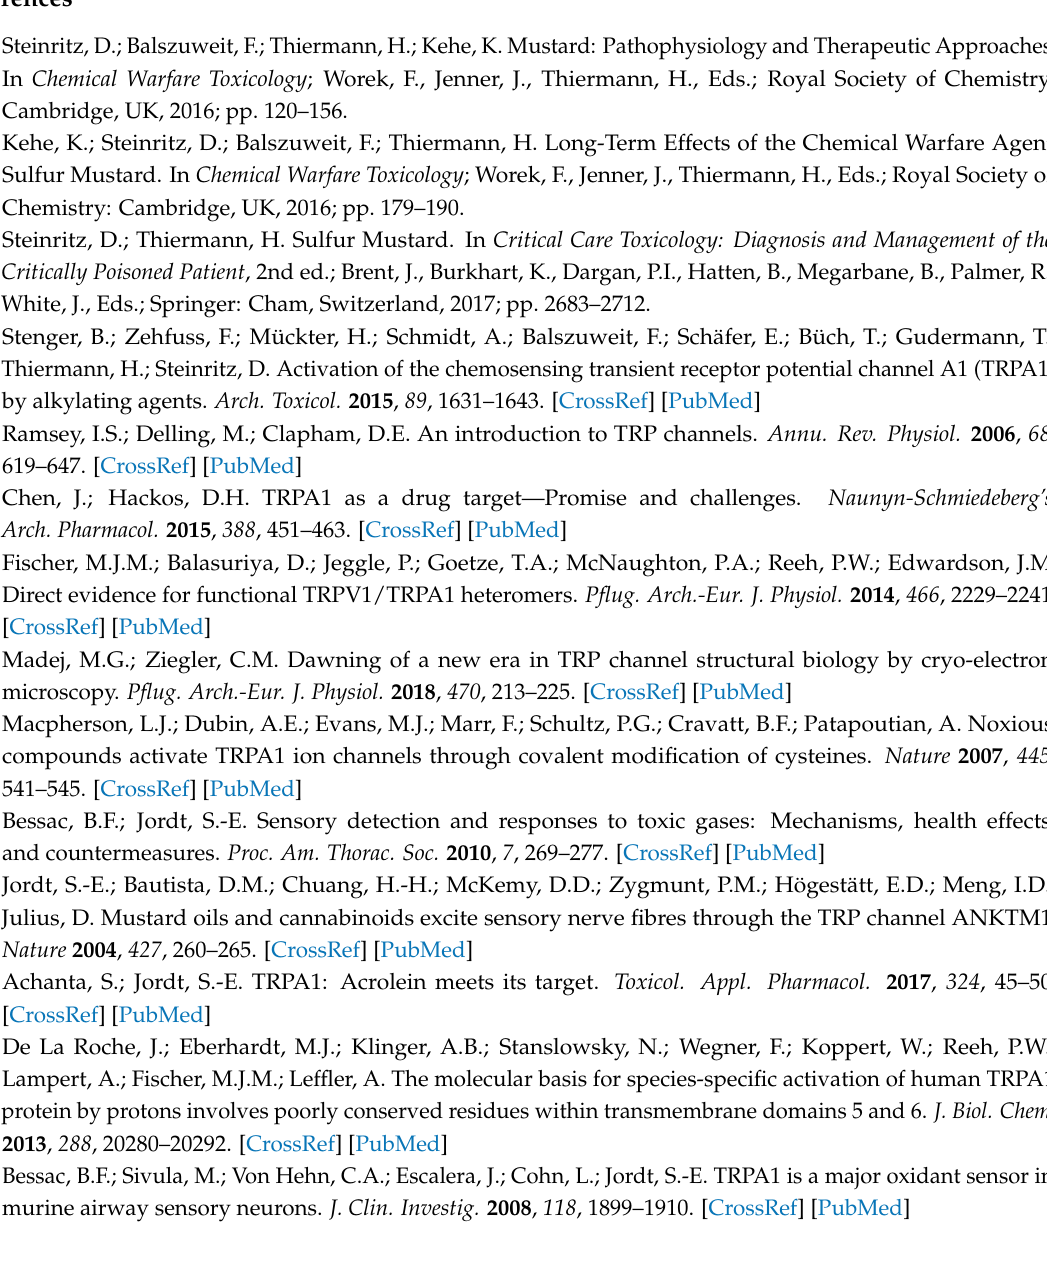
Figure S1. Representative 2D silver-stained gel electrophoresis of 600 µ M SM-exposed HEKA1 cells. Figure S2. RT-qPCR measurements of relative HSPA6 mRNA levels in HEKA1 and HEKwt cells. Table S1. Fold change values of